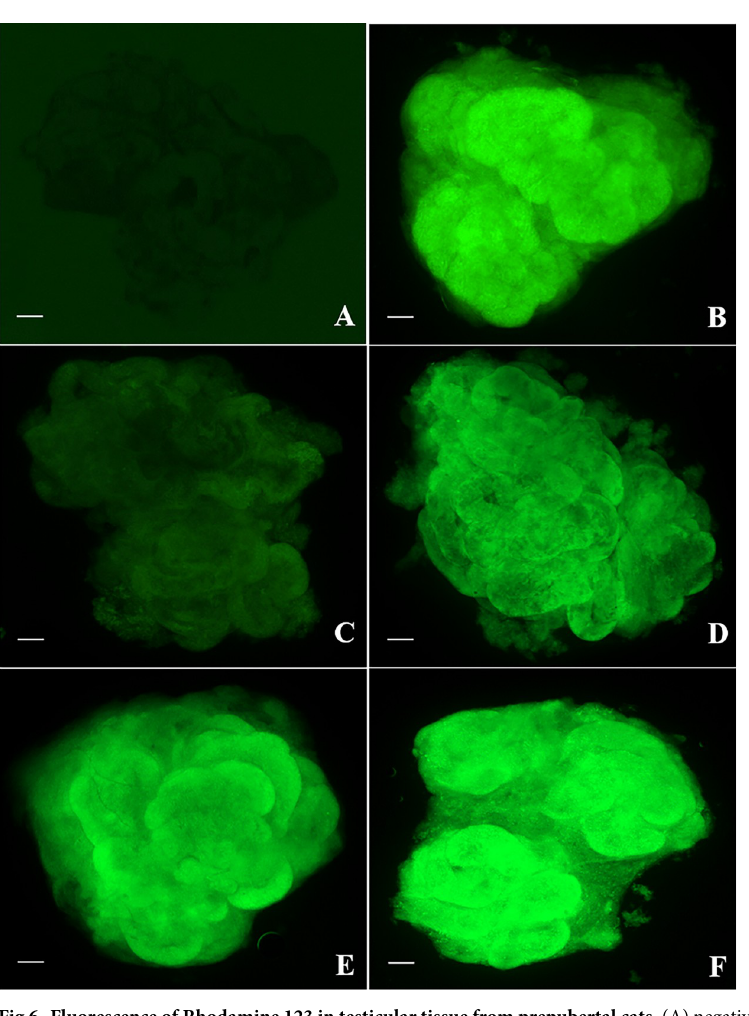
Fig 6. Fluorescence of Rhodamine 123 in testicular tissue from prepubertal cats. (A) negative control, (B) fresh tissue, (C) Warming 1 (tissue warmed at 37˚C), (D) culture 1 (warming 1 followed by culture for 24h), (E) warming 2 (warmed at 50˚C), (F) culture 2 (warming 2 followed by culture for 24h). Bar = 2 μ m.